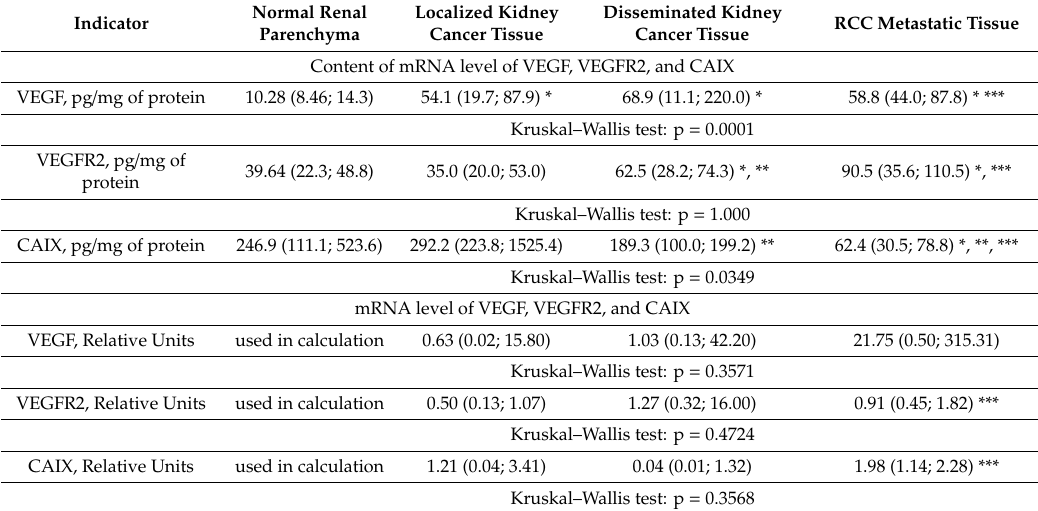
Table 3. The content and mRNA level of VEGF, VEGFR2 receptor and CAIX in a kidney tumor in patients with localized and disseminated kidney cancer, as well as in metastatic sites. Normal Renal Localized Kidney Disseminated Kidney RCC Metastatic Indicator Parenchyma Cancer Tissue Cancer Tissue